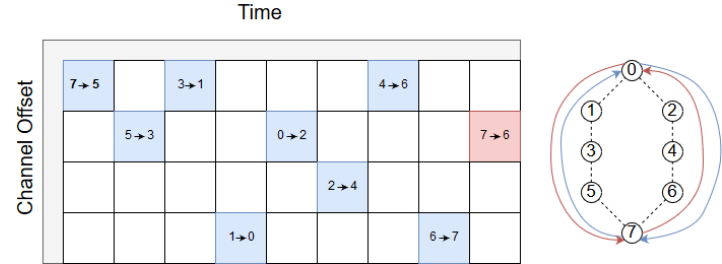
Figure 3. Example of a Path Computation Element (PCE) scheduling tracks from source to